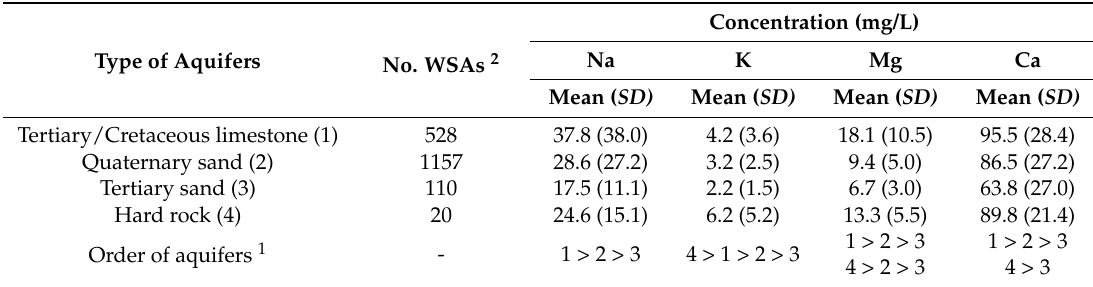
Table 3 . Comparison of mean drinking water concentrations of Na, K, Mg and Ca between the four main aquifer types.